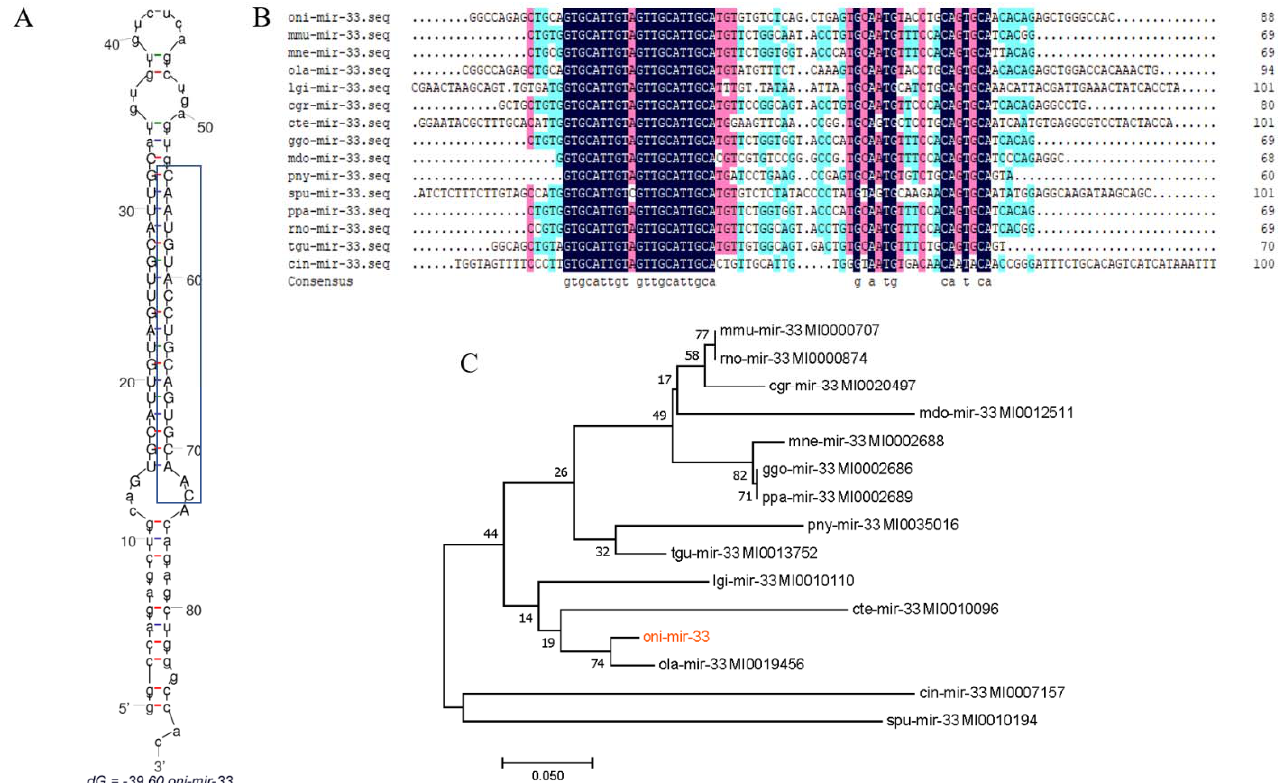
Figure 4. Characteristics of miR-33. ( A ) Hairpin structures of oni-mir-33 from Oreochromis niloticus . Blue box shows mature miR-33 sequence (oni-miR-33). ( B ) Analysis of Pre-mir-33 sequence by Multiple Sequences Alignment. ( C ) The phylogenetic tree was constructed by the neighbor-joining method using MEGA 7.